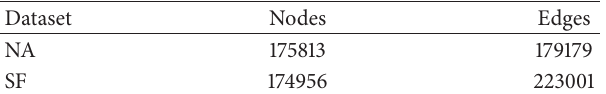
Algorithm 4: findMaxSegments( 𝐹 ). Table 1: Cardinalities of real datasets.